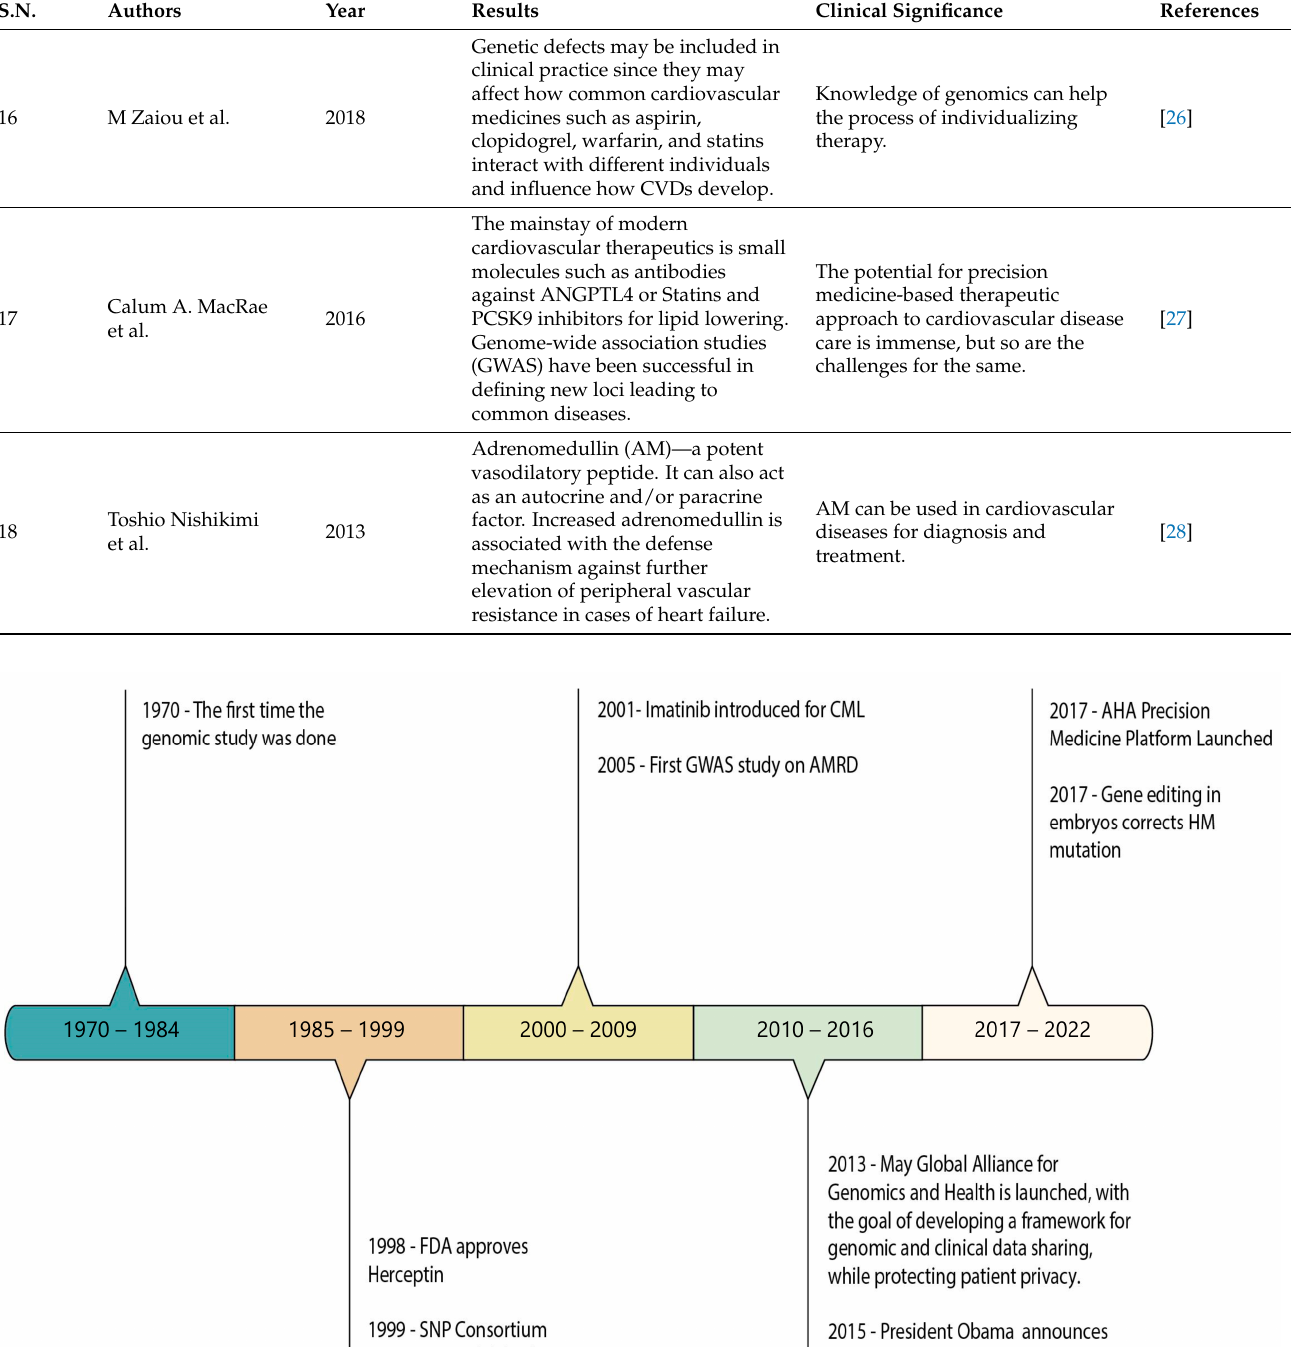
Figure 2. Timeline of the evolution of precision medicine in cardiology. Table 1. A compilation of important reviews underlining the role of precision medicine in cardiol- ogy.